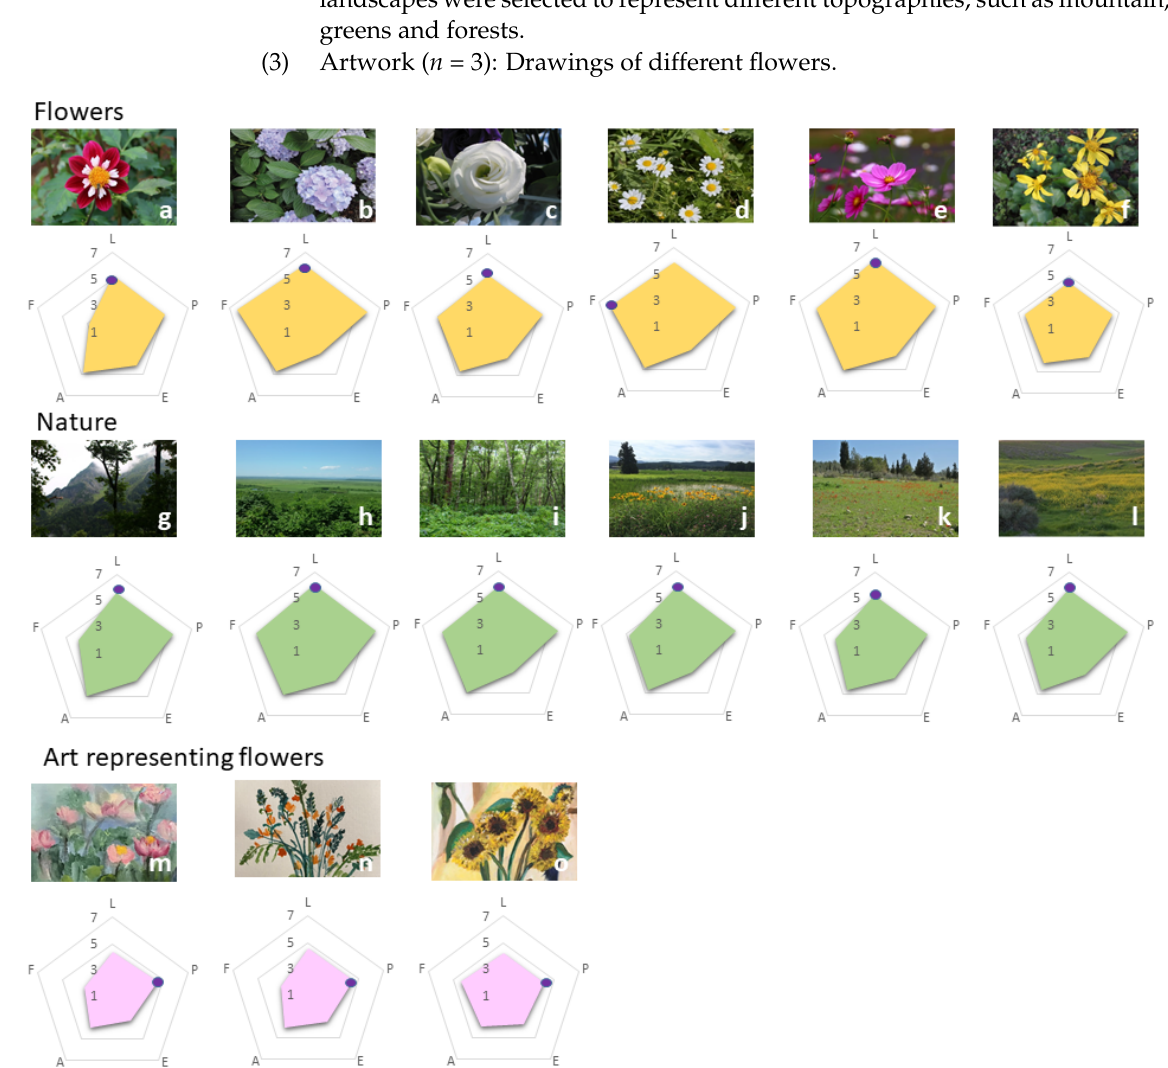
Figure 1. Images used in the survey and their scores on the 7-point Likert-type rating scale (see Methods) represented as bar charts. Images are presented by groups. Flowers: ( a ) white and red dahlia, ( b ) blue hydrangea, ( c ) white lisianthus, ( d ) white marguerite, ( e ) pink cosmos, ( f ) yellow leopard plant. Nature: ( g ) tree and mountains (Kamikochi, Japan), ( h ) trees with open landscape (Kushiro swamp, Japan), ( i ) greens and woods (Kamikochi, Japan), ( j ) yellow flowers (Okkaido, Japan), ( k ) red flowers and greens (Negev, Israel), ( l ) yellow flowers (Negev, Israel). Art representing flowers: ( m ) lotus, ( n ) Ornithogalum and ( o ) sunflowers. Y axis represents the average score obtained for each image on a scale from 1 to 7 (see